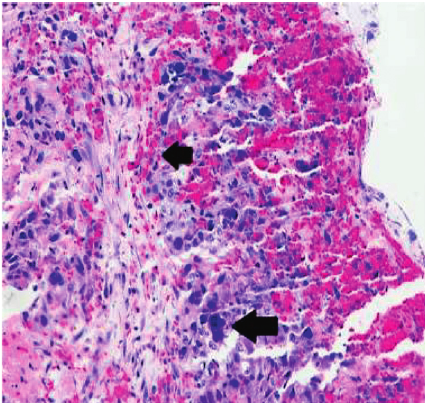
Figure 2: Upper arrow: clusters of cytotrophoblast and hemor- rhage; lower arrow: syncytiotrophoblast.